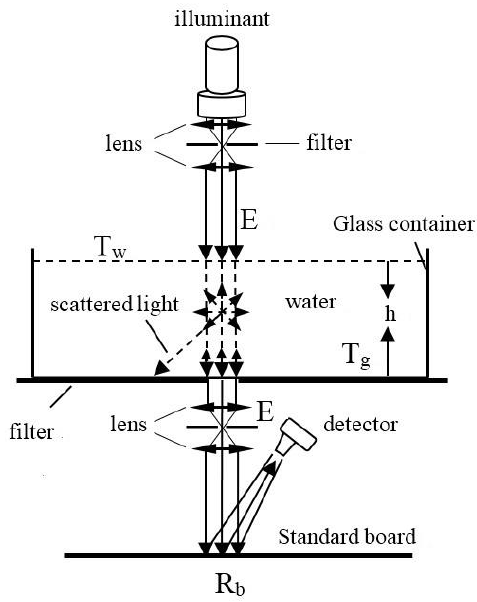
Figure 6. Schematic diagram of an optical parameter measuring device.